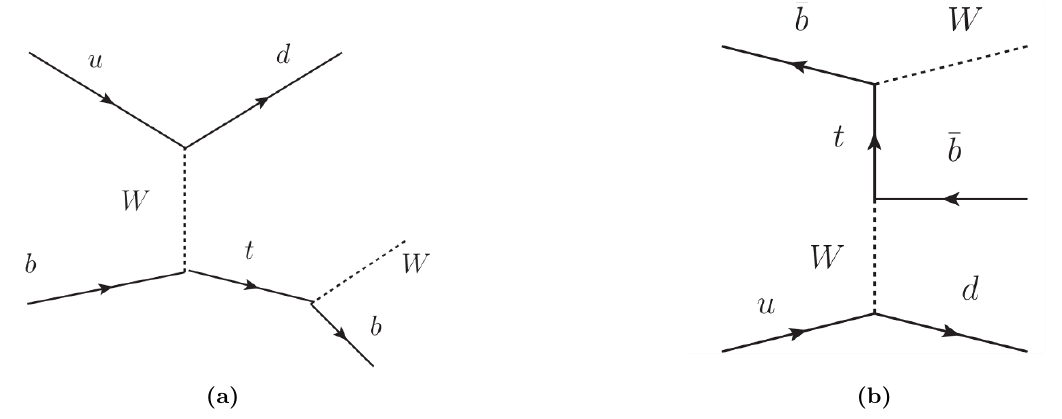
Figure 2. Leading-order Feynman diagrams for the SM processes that interfere with T -quark or Y - quark production, respectively, as described in the text: (a) t -channel single-top-quark production where the top quark is far o(cid:11)-shell and (b) electroweak W (cid:0) bq production. (cid:20) T = 0.5 are corrected on an event-by-event basis using reweighting factors. These